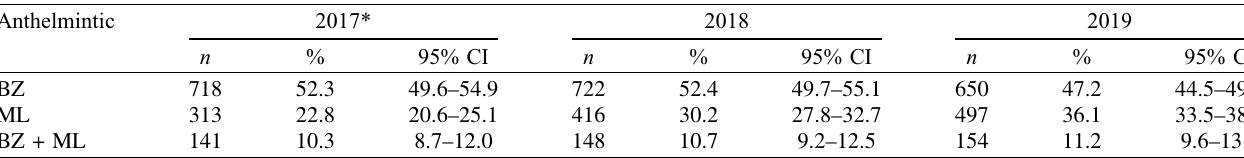
Table 3. Anthelmintics against GINs used during 2017 – 2019, according to the farmer responses ( n = 1378): Benzimidazoles (BZ), Macrocyclic lactones (ML), and combination of both anthelmintic classes (BZ + ML).